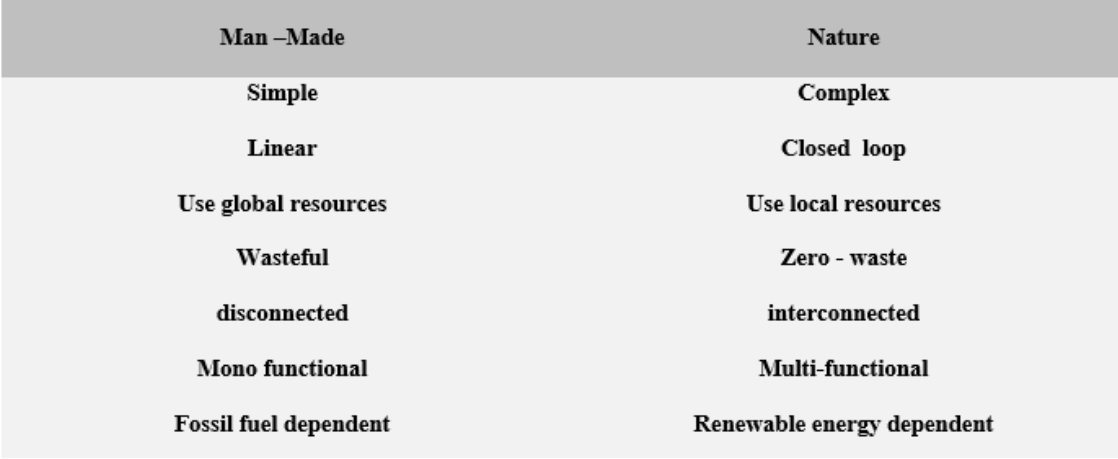
Figure 6: Comparison between Man Made and nature’s